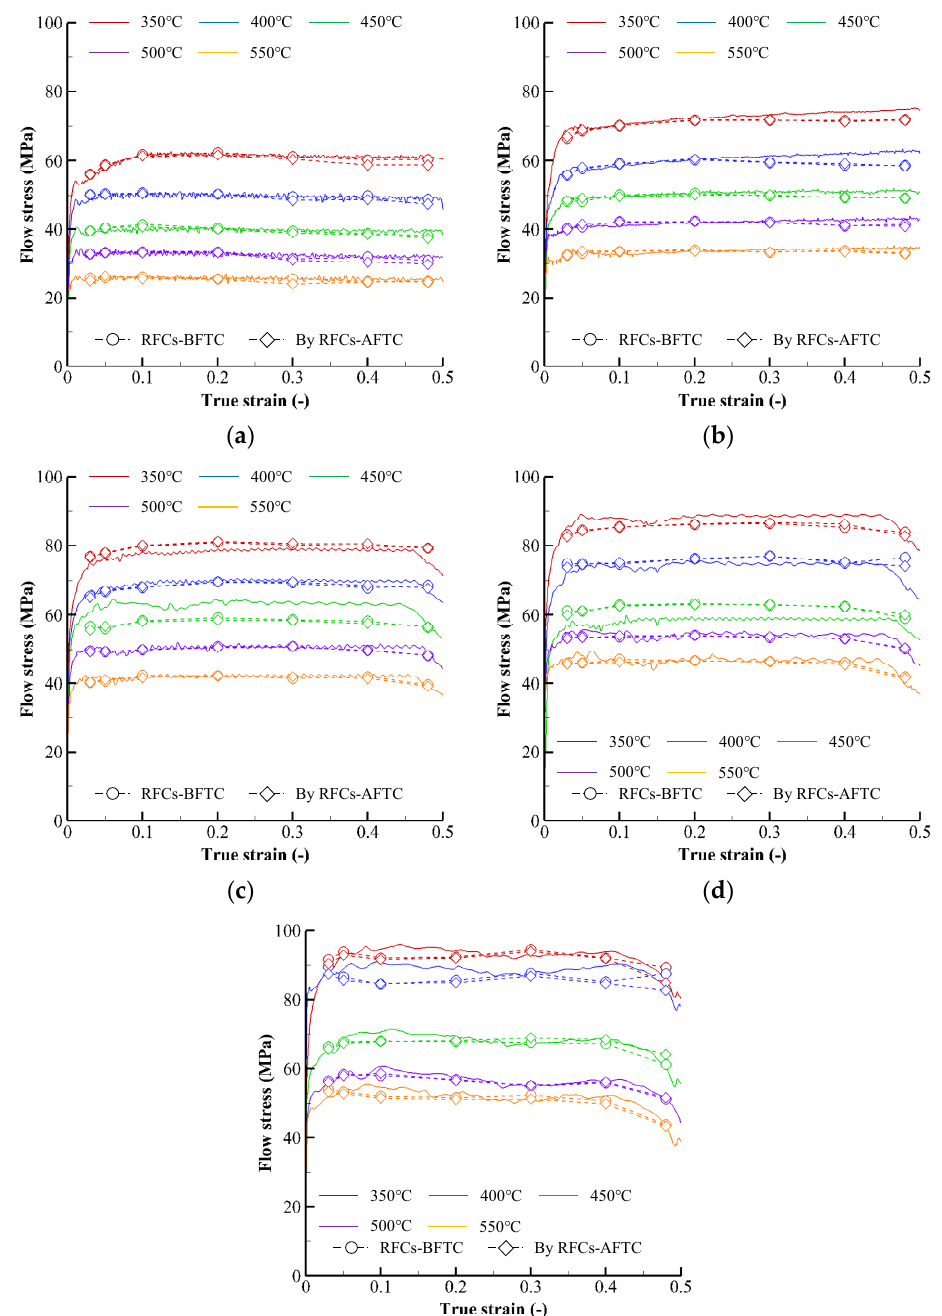
Figure 7. Experimental CLSCs and their predictions by RFCs–AFTCs and RFCs–BFTCs: ( a ) 0.1 s − 1